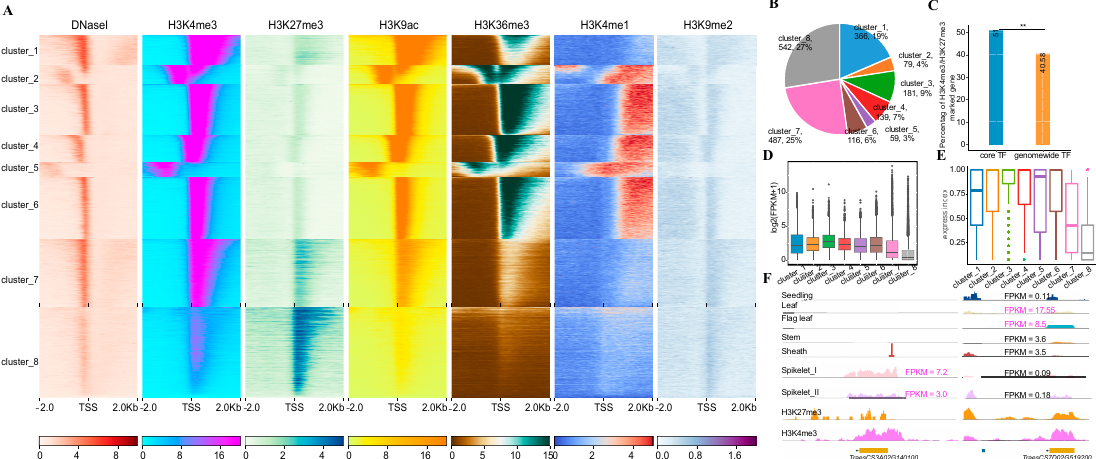
Figure 4. Epigenetic landscapes of expressed core genes. ( A ), Chromatin states were performed on the upstream and downstream 2 kb of the expressed core gene promoters. A total of eight subcategories were classified, C7/C8 was enriched with H3K27/K4me3. ( B ), The proportion of TFs in different chromatin states, C7/C8 occupied 50% of the TFs. ( C ), Comparisons of core TFs with H3K4/K27me3 bivalent mark between C7/C8 and the whole genome. ( D , E ), Analyses of the core gene expression values ( D ), and the expression breadth ( E ) corresponding to different chromatin states. Genes with higher active histone modifications correspond to higher gene expression levels and lower tissue specificity, and vice versa. ( F ), IGV illustrates genes for spikelet-( left ) and leaf-( right ) specific expression, respectively. Where ** means p <